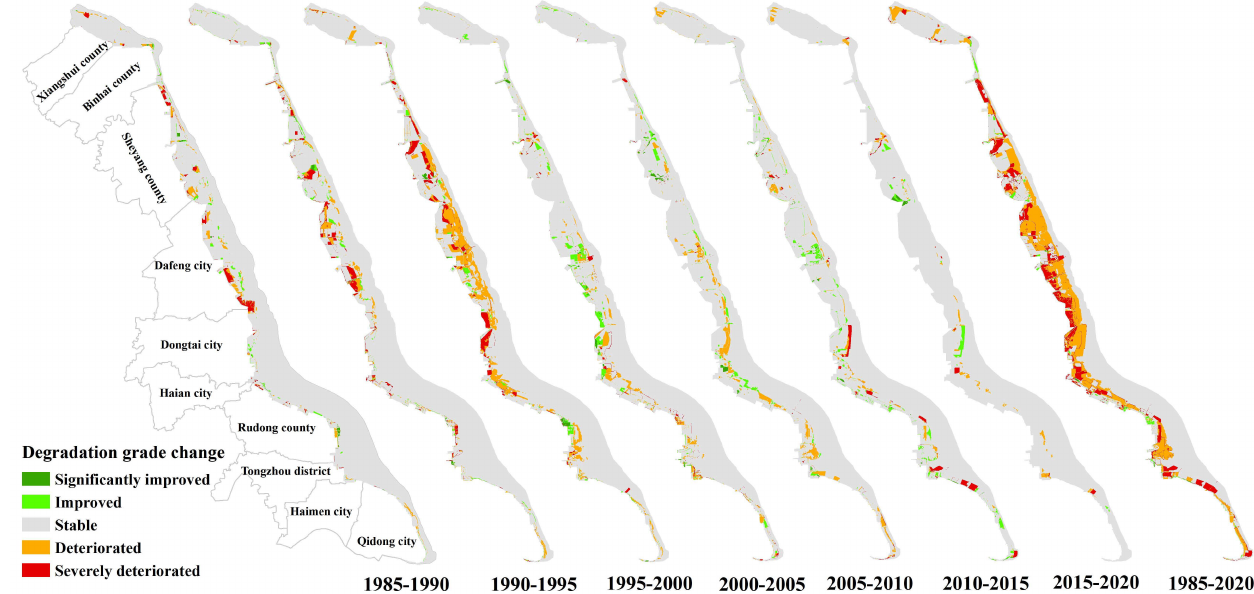
Figure 8. Spatial distribution of coastal wetland degradation grade changes in the study